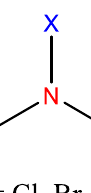
Figure 2. Schematic representation of the general structure of N -halamine compounds.